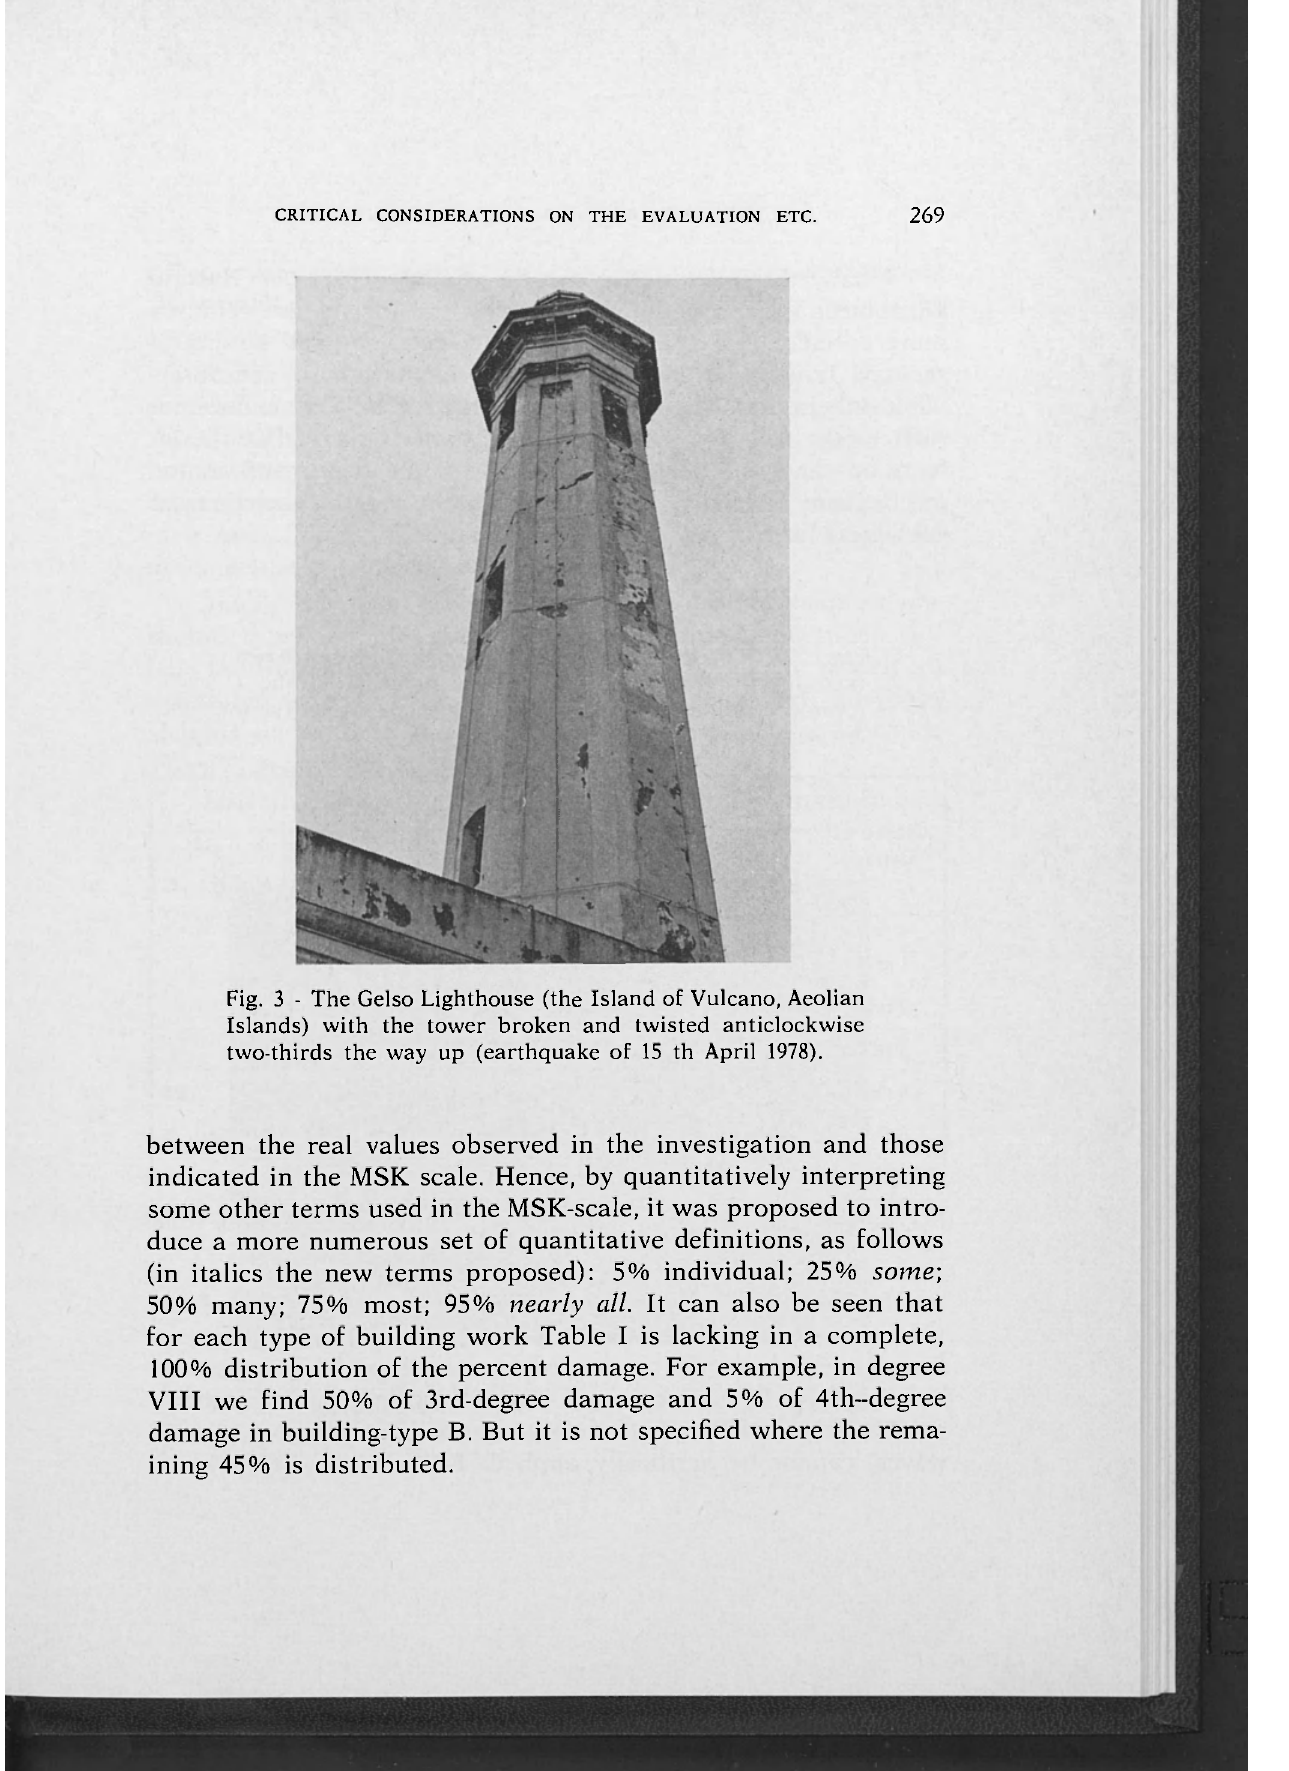
Fig. 3 - The Gelso Lighthouse (the Island of Vulcano, Aeolian Islands) with the tower broken and twisted anticlockwise two-thirds the way up (earthquake of 15 th April